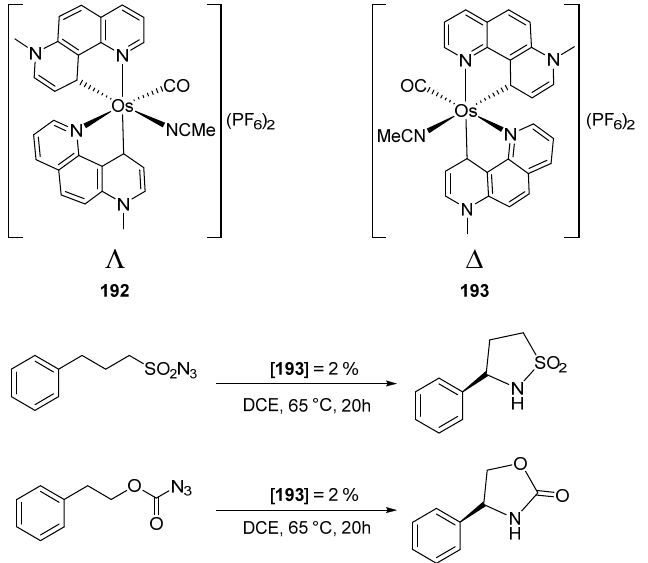
Figure 45. Asymmetric catalysis by cyclometalated osmium complexes with central chirality. Octahedral cyclometalated 2-phenylpyridine Ru II and Os II complexes were investi- gated as catalysts for the atom transfer radical polymerization (ATRP). Polymerization of styrene was catalyzed by ruthenium complexes though the osmium counterparts were not able to mediate the polymerization and just traces of the polymer were observed [108].